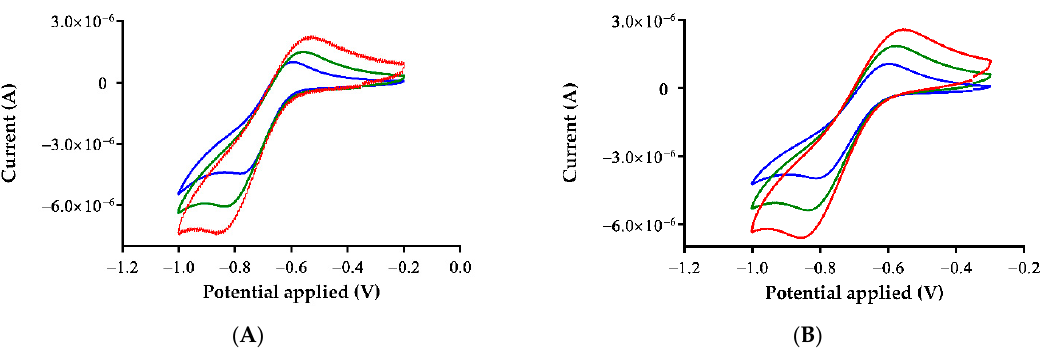
Figure 1. Cyclic voltammograms for ( A ) 1 and ( B ) 2 at different scan rates: 0.02 V s − 1 (blue), 0.05 V s − 1 (green) and 0.09 V s − 1 (red).